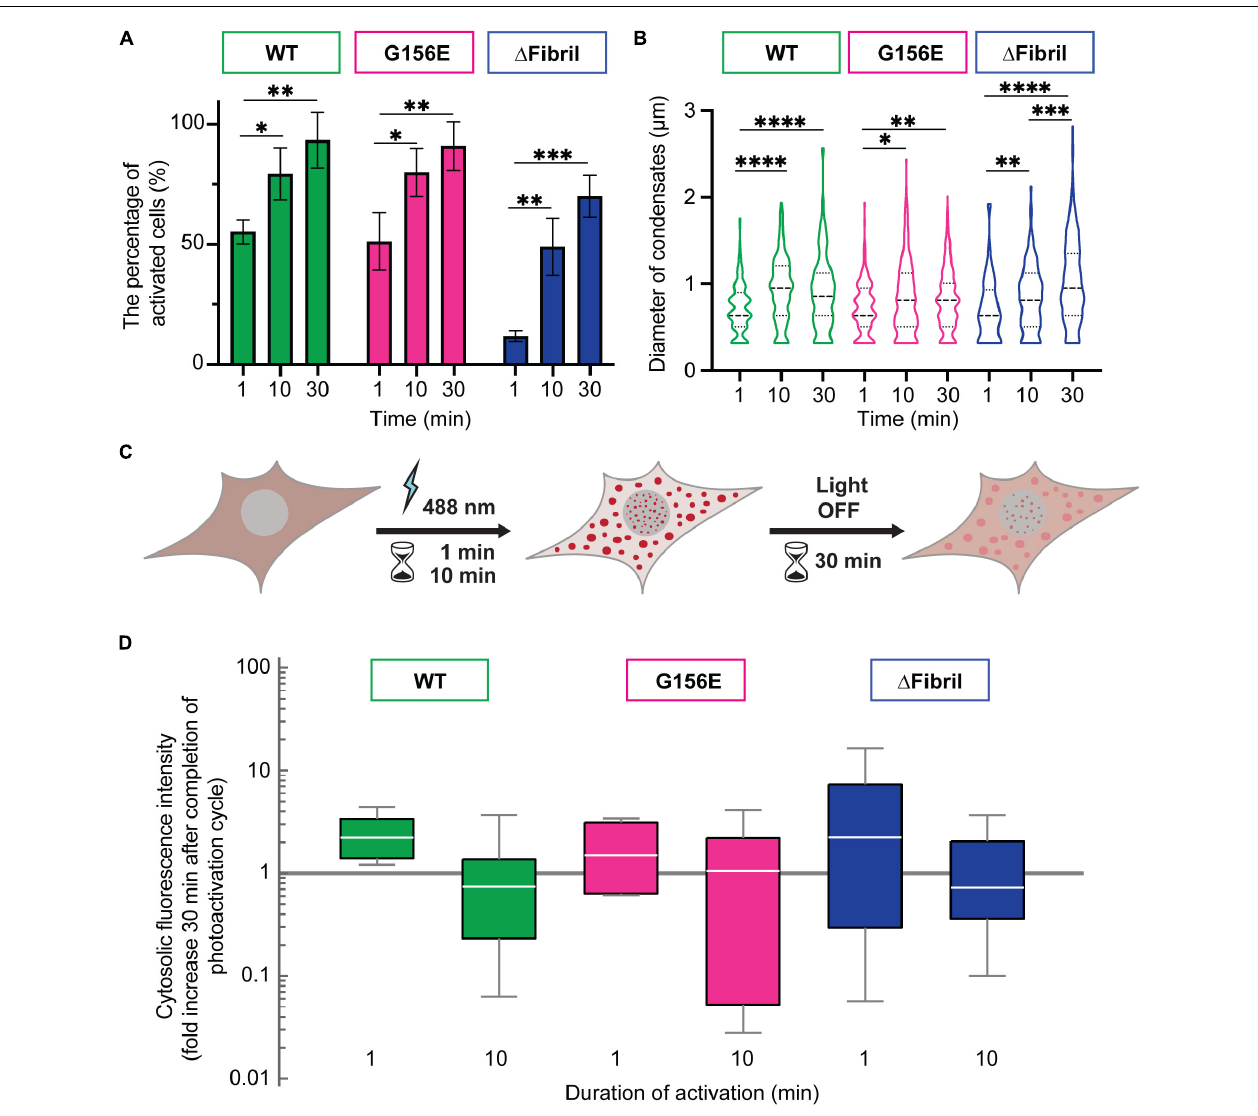
FIGURE 2 | Longer photoactivation promotes FUS condensation. (A) The percentage of activated cells after 1, 10, or 30 min of activation (0.15 mW 488 nm-laser power) for WT (green), G156E (magenta) and (cid:49) Fibril (blue) FUS. (B) Same as (A) , but now showing the diameter of condensates (dashed line—median value; dotted line—interquartile range). (C) Scheme of the imaging-based assay for determining the enrichment of FUS in condensates after completion of photoactivation. Cytosolic signal intensity is compared immediately after photoactivation with the intensity 30 min after the activation laser is turned off. (D) Box-Whisker-Plots showing fold change of cytosolic fluorescence intensity 30 min after photoactivation (1 or 10 min) at 0.15 mW 488 nm-laser power for WT (green), G156E (magenta) and (cid:49) Fibril (blue) FUS. Bars represent average values with standard deviation. ∗ P < 0.05, ∗∗ P < 0.01, ∗∗∗ P < 0.001, ∗∗∗∗ P < 0.0001 two-sided, unpaired t -test; each experiment is done in three different rounds of